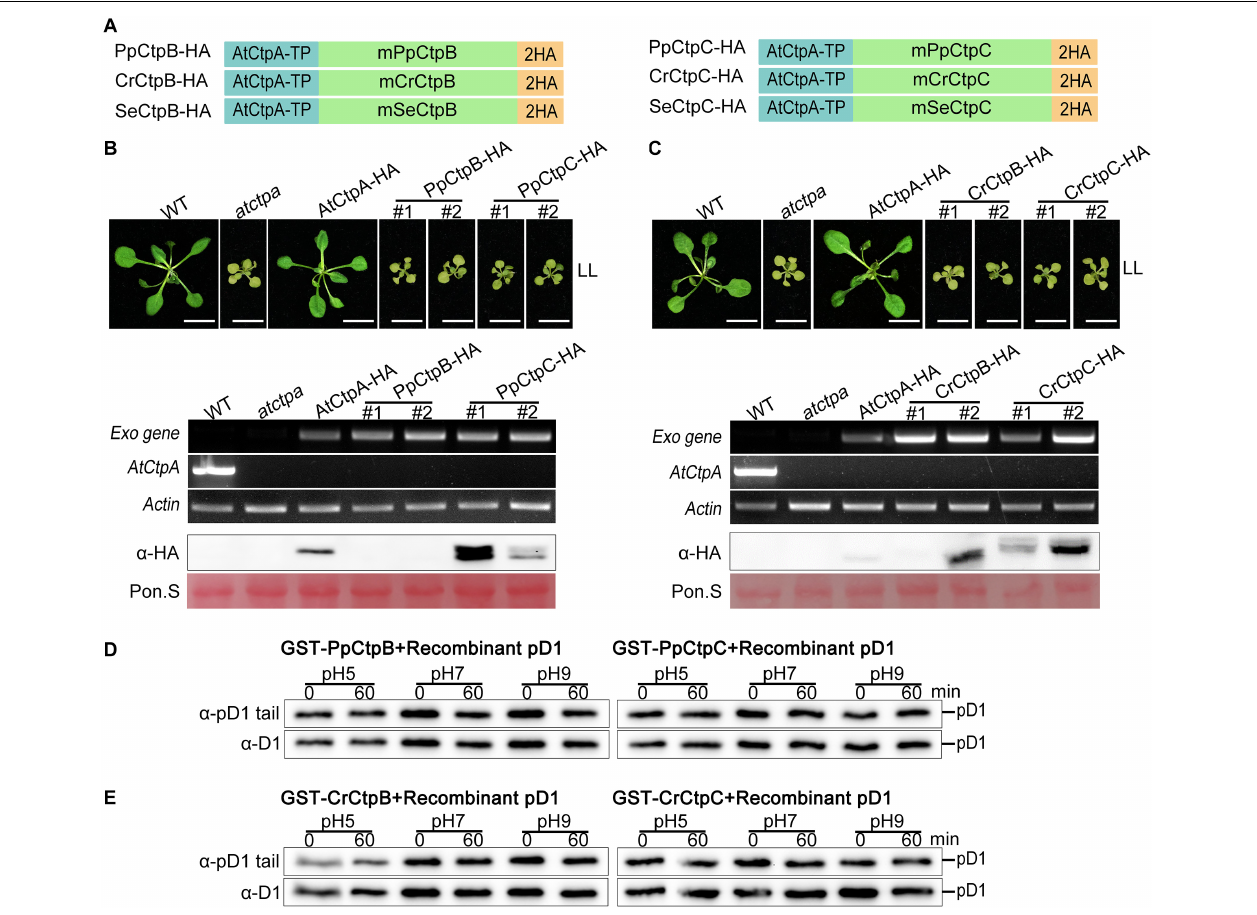
FIGURE 8 | Proteolytic activity of CtpB and CtpC from lower photosynthetic organisms for pD1 processing. (A) Schematic diagrams of PpCtpB-HA or PpCtpC-HA (from P. patens ), CrCtpB-HA or CrCtpC-HA (from C. reinhardtii ), and SeCtpB-HA or SeCtpC-HA (from S. elongatus ). AtCtpA-TP is the N-terminal chloroplast transit peptide of AtCtpA; mPpCtpB or C, mCrCtpB or C, and mSeCtpB or C are the mature proteins; 2HA is a double hemagglutinin tag. (B,C) Ectopic expression of PpCtpB-HA or PpCtpC-HA and CrCtpB-HA or CrCtpC-HA driven by the CaMV 35S promoter in atctpa was analyzed as described in the legend of Figure 7 . (D,E) In vitro protease activity of PpCtpB or C and CrCtpB or C were assayed with recombinant AtpD1 as substrate as described in the legend of Figure 4 .